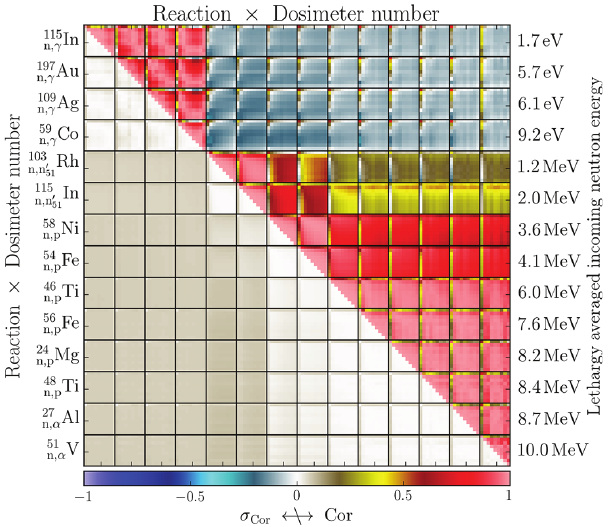
Fig. 11. Inter-dosimeter correlations associated to the propa- gation of the iron cross section uncertainties on the dosimeters reaction rates (top-right diagonal), with its standard deviation (bottom-left diagonal) estimated with a Jackknife resampling technique